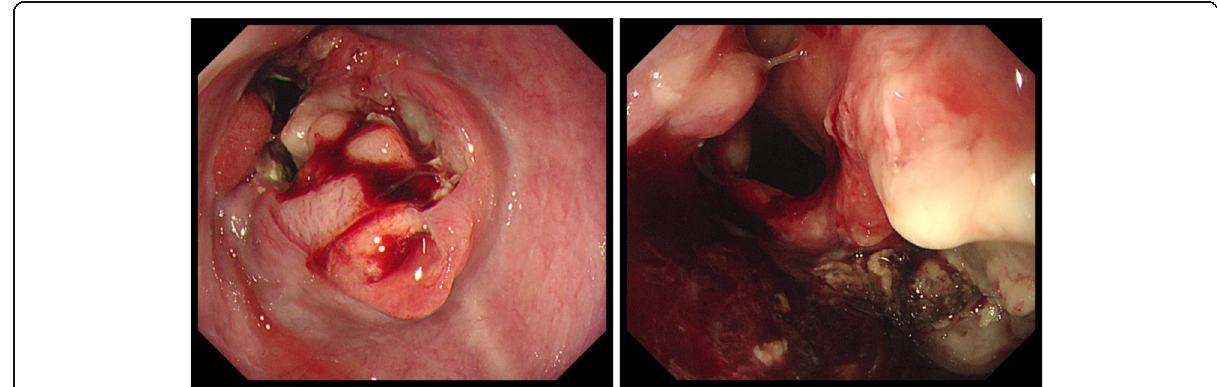
Fig. 2 Esophagogastroduodenoscopy (EGD) revealed an ulcerated mass, 33 to 40 cm from the